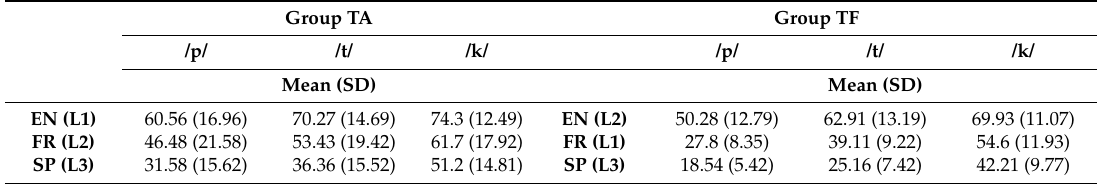
Table 3. Summary of VOT means in all languages from both experimental